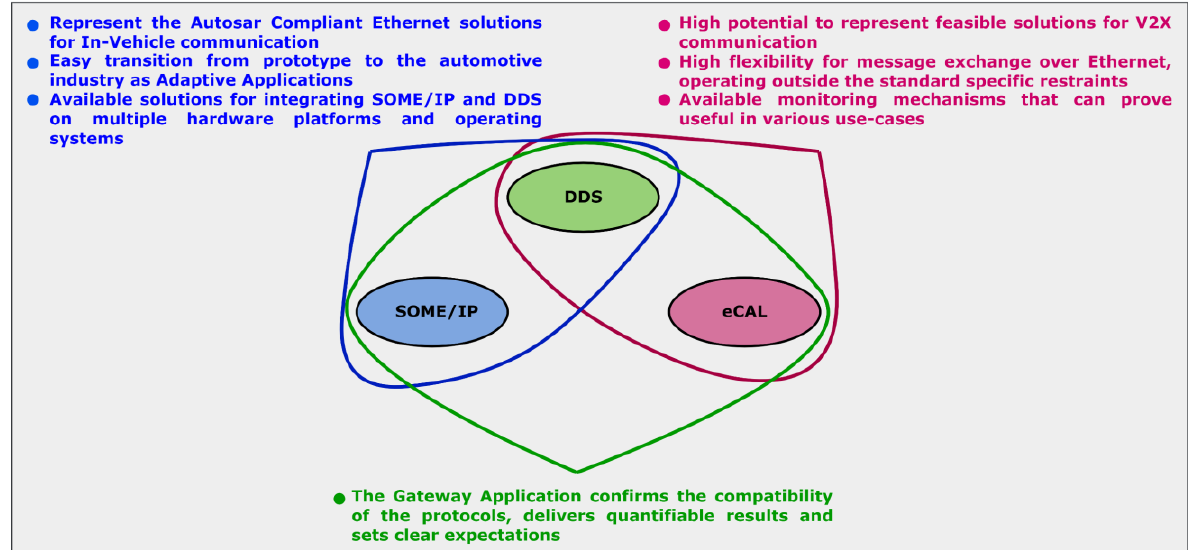
Figure 10. An overview of the utilized technologies.